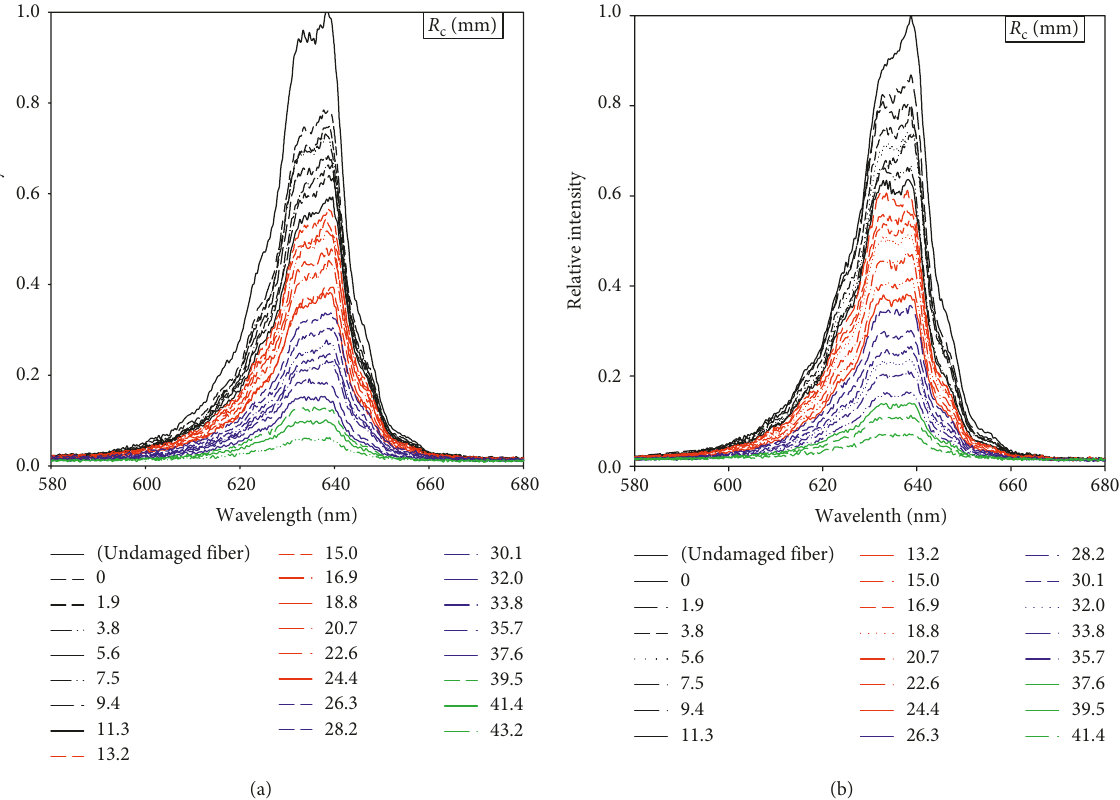
Figure 11: End-tip-illumination using two types of cladding removal for PGR-FB250 fiber with different cut areas. (a) Whole-cut [1]. (b) One-sided removal.